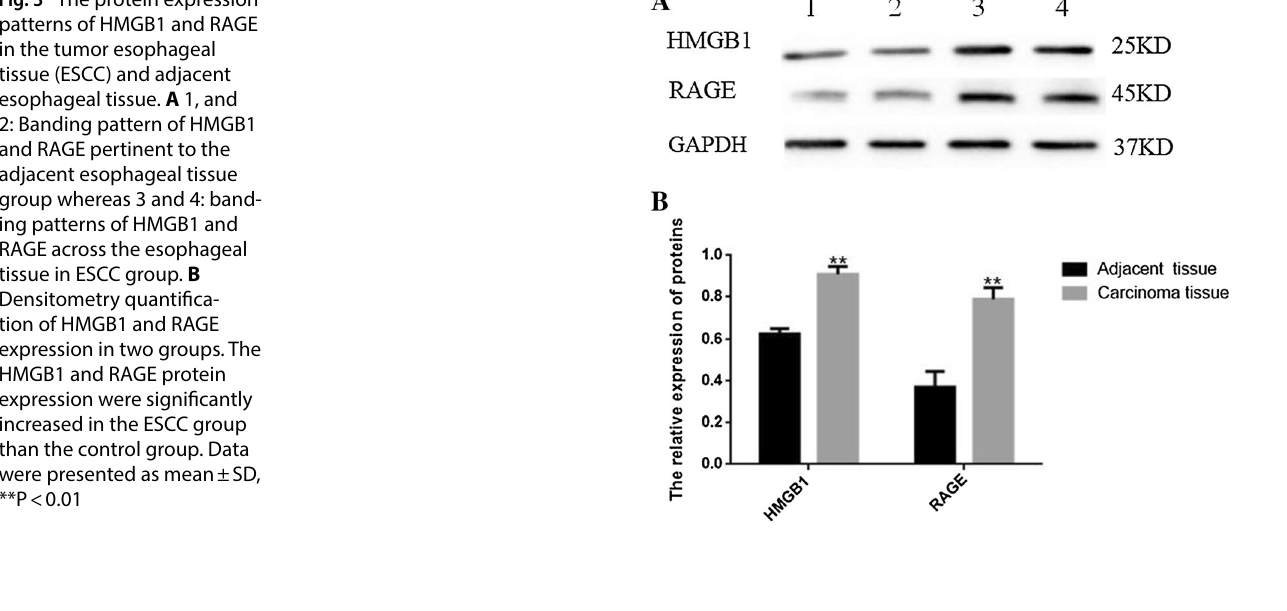
Table 3 Correlation between HMGB1 expression and clinicopatholological characteristics of the patients